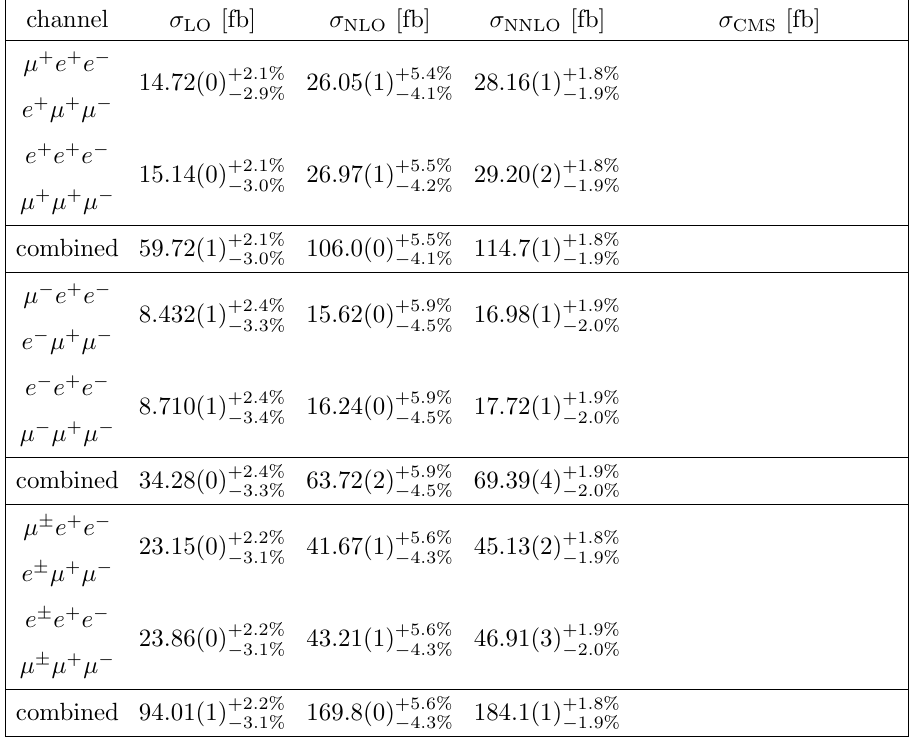
Fiducial cross sections for CMS 8 TeV. Note that due to the (cid:13)avour-unspeci(cid:12)c lepton cuts the theoretical predictions are (cid:13)avour-blind, which is why the results are symmetric under e (cid:22) exchange. No CMS data for the (cid:12)ducial cross sections available at 8 TeV. \Combined" refers $ to the sum of all separate